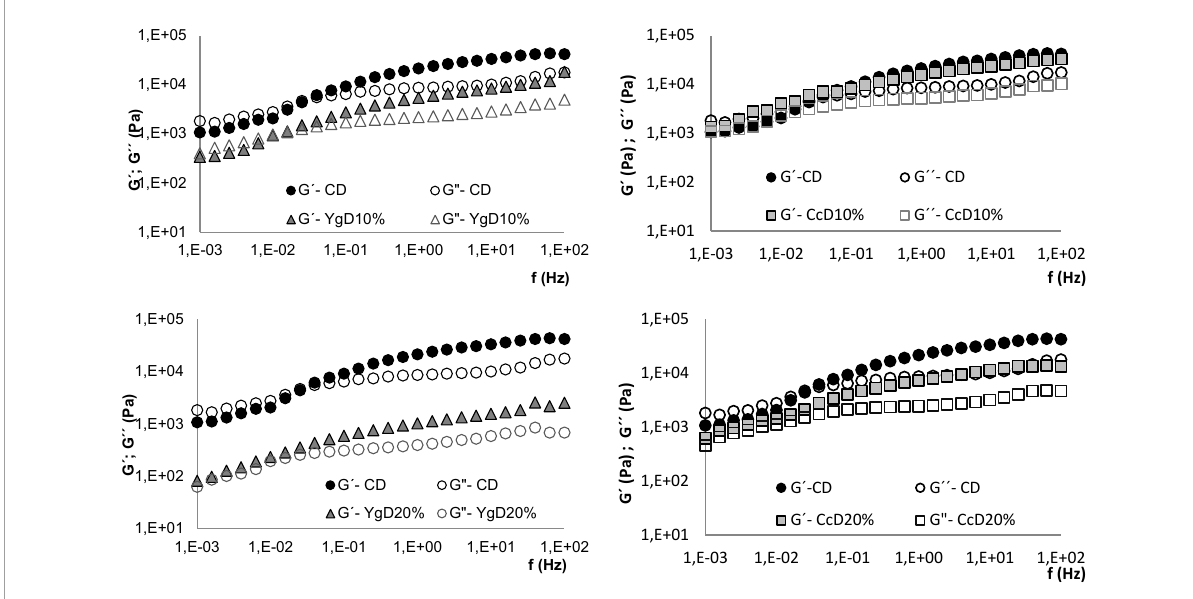
FIGURE3 Changes in gluten-free dough viscoelastic behavior, elastic (G (cid:48) ) and viscous (G (cid:48)(cid:48) ) moduli, promoted by different levels of yogurt and curd cheese additions (YgD and CcD at 10 and 20%) compared to control dough (CD).